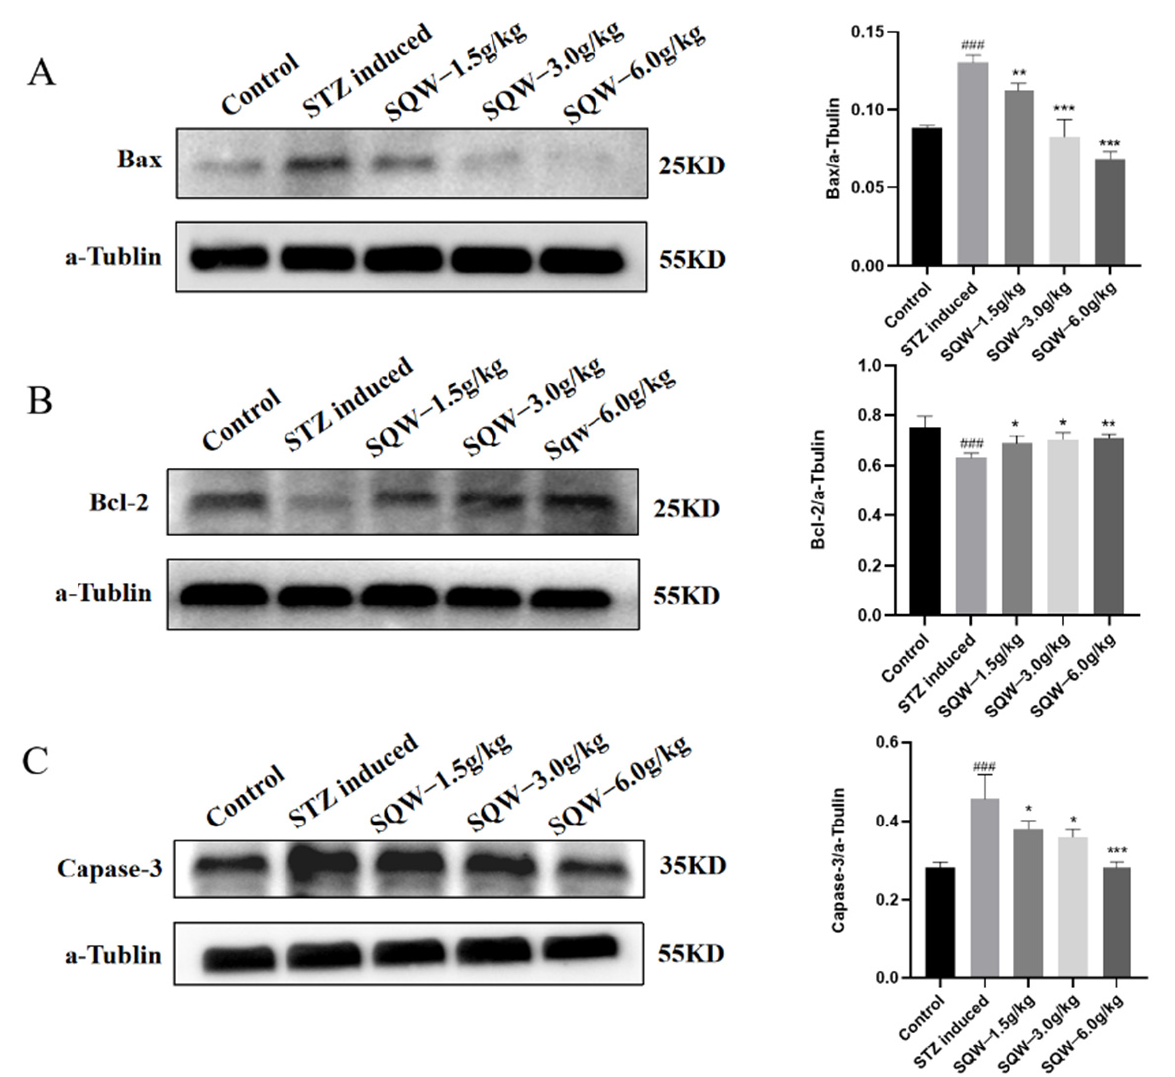
Figure 5. The effect of SQW on the protein expression levels of Bax, Bcl-2, and Caspase-3. ( A ) The effect of SQW on Bax. ( B ) The effect of SQW on Bcl-2. ( C ) The effect of SQW on Caspase-3. All of the results are expressed as means ± SD, n = 3 per group. Compared with the control group, ### p < 0.001; compared with the STZ induced group, * p < 0.05, ** p < 0.01, *** p < 0.001.